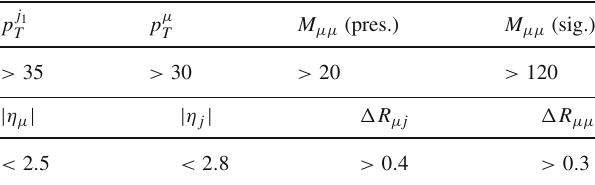
Table 3 Cuts applied at parton-level to efficiently simulate events at √ s = 13 TeV in the preselection region and signal